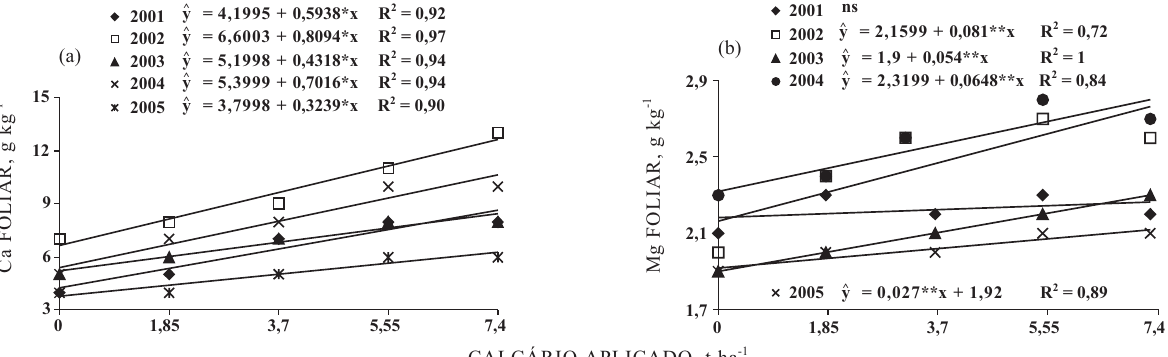
Figura 4. Efeito da aplicação de doses crescentes de calcário sobre os teores foliares de Ca (a) e Mg (b), no pomar de goiabeiras, avaliados em diferentes anos (dados médios de quatro repetições). ** Significativo p < 0,01 e * Significativo p <